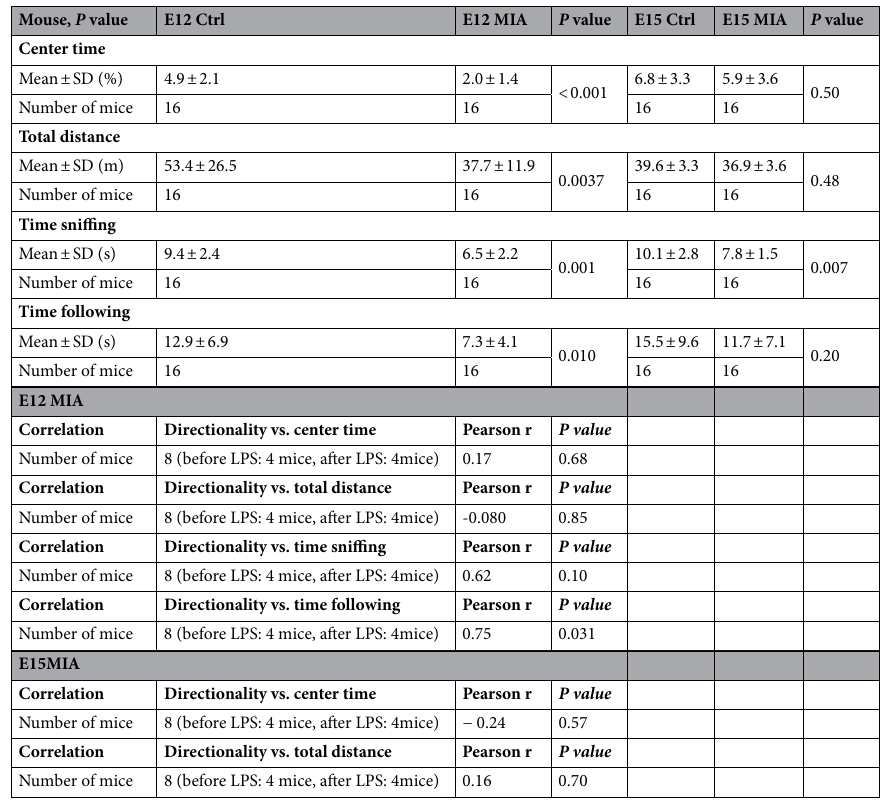
Table 8. Behavioral analysis in late adolescent